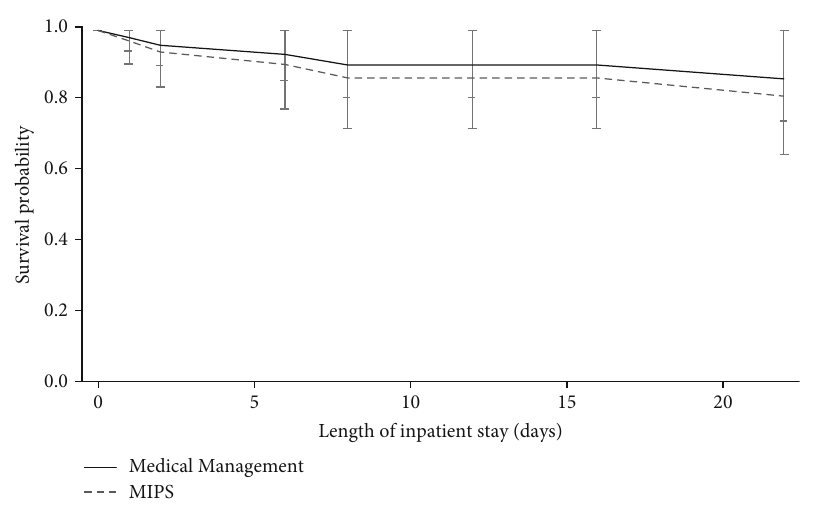
Figure 2: Adjusted survival from admission by the treatment group. Bars represent 95% con fi dence